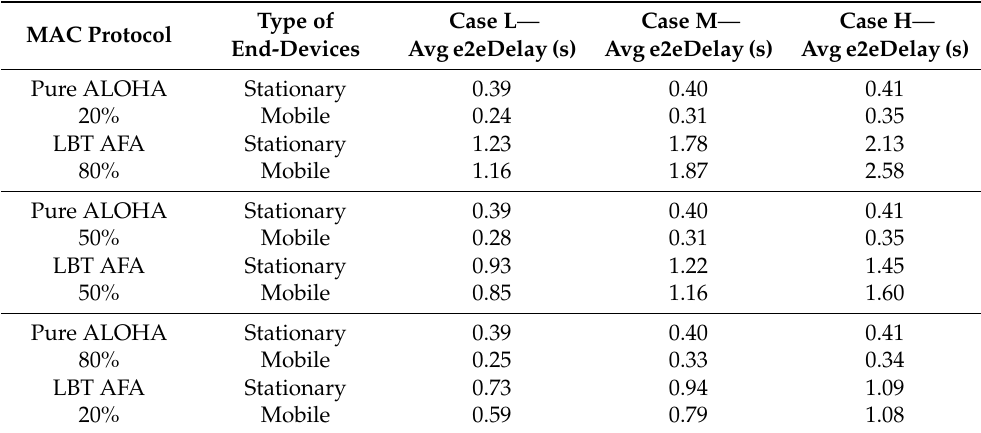
Table 12. Average e2eDelay with varying percentages of end-devices that use Pure ALOHA and LBT